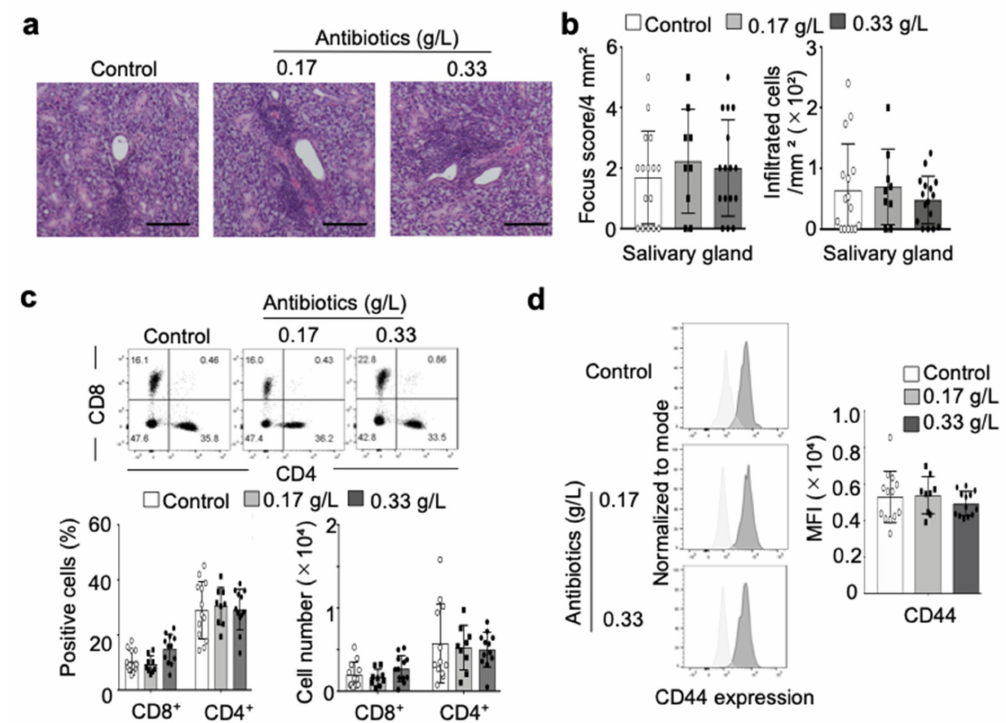
Figure 4. Effect of antibiotic administration on autoimmune lesions in salivary gland tissues of NOD mice. ( a ) Pathological images of salivary gland tissues were shown. Images are of representative mice in each group. Scale bar: 100 µ m. ( b ) Focus score per 4 mm 2 was assessed using pathological sections. Number of infiltrated cells within salivary gland tissues (1 mm 2 ) were histologically semi-quantified, and data are presented as mean ± SD of 16 mice in control and 0.33 g/L groups and 9 mice in the 0.17 g/L group. ( c ) T cell populations in salivary gland tissues were detected by flow cytometric analysis. Proportion and number of CD4 + or CD8 + T cells were calculated, and data are presented as mean ± SD of 13 mice in control and 0.33 g/L groups, and 9 mice in the 0.17 g/L group. ( d ) CD44 expression on CD4 + T cells in salivary gland tissues was measured by flow cytometric analysis. Data are presented as mean fluorescence intensity of CD44 expression ± SD of 13 mice in control and 0.33 g/L groups and 9 mice in the 0.17 g/L